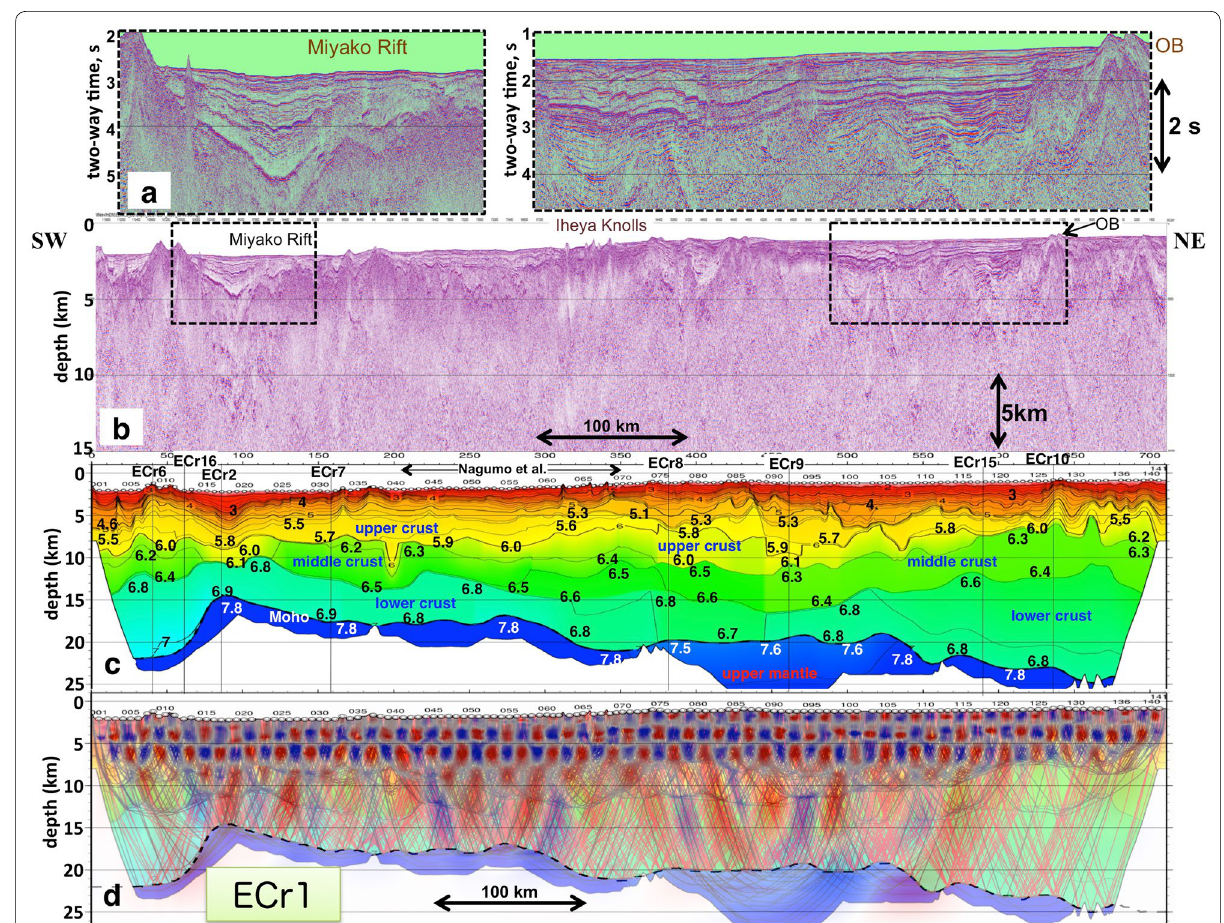
Fig. 13 a Enlarged MCS time sections in the dashed frames in the MCS depth section b for ECr1. c V p model. d Checkerboard test result with ray coverage. OB Okigaja